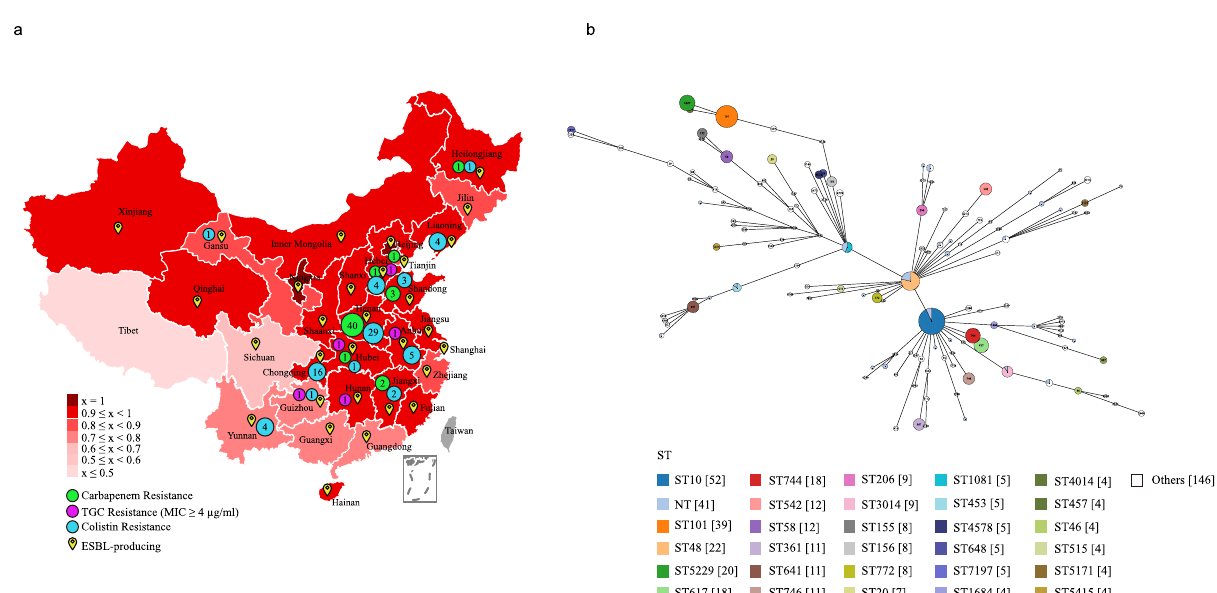
Fig. 2 Distribution and sequence types of multidrug-resistant E. coli isolates from Chinese pig farms. a A map of China showing the percentages of multidrug-resistant E. coli isolates from pig farms in different provinces of China ( “ x ” refers to percent multidrug-resistant isolates); different colors represent percentages; small circles in green, purple and blue show the distribution of carbapenem-resistant, colistin-resistant, and tigecycline-resistant E. coli isolates, respectively; numbers in small circles represent the numbers of carbapenem-resistant, colistin-resistant, and tigecycline-resistant E. coli isolates, respectively, in different provinces; ESBL-producing E. coli isolates are also indicated. b Analysis of the minimum spanning tree of the 515 sequenced E. coli isolates based on the sequence type. TGC tigecycline, ESBL extended-spectrum beta-lactamase, MLST multilocus sequence typing, ST sequence